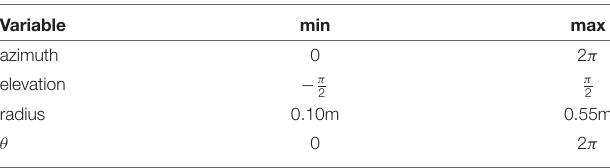
TABLE 1 | Ranges from which the absolute viewpoints are sampled in spherical coordinates in the dataset creation process.